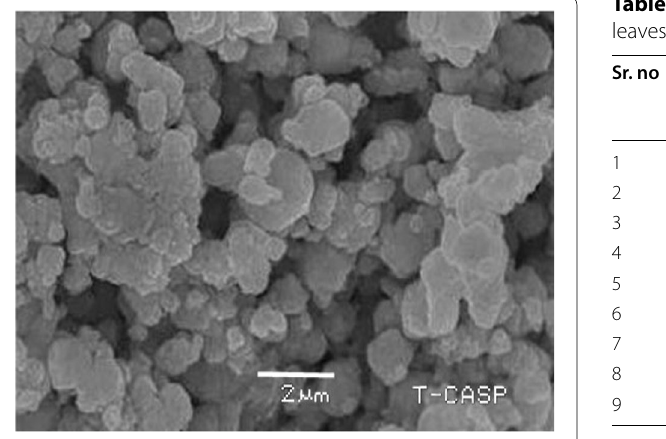
Table 1 Minimum inhibitory concentration of Grewia asiatica